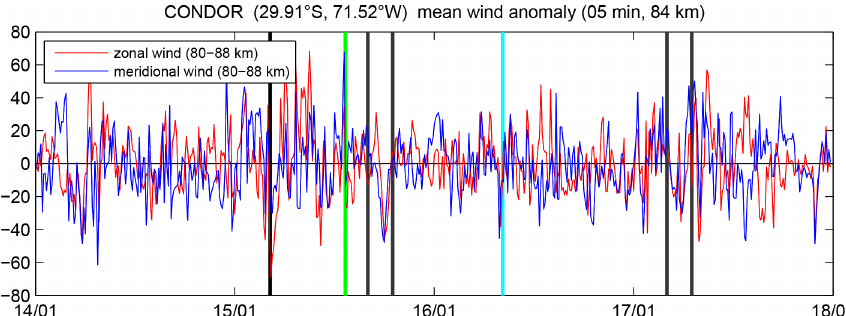
Figure 6. The same as Fig. 4 but using the 5min temporally resolved wind data. The vertical green and cyan lines indicate the arrival of the lamb wave along the great circle assuming a propagation velocity of 310ms − 1 for the short and long paths,